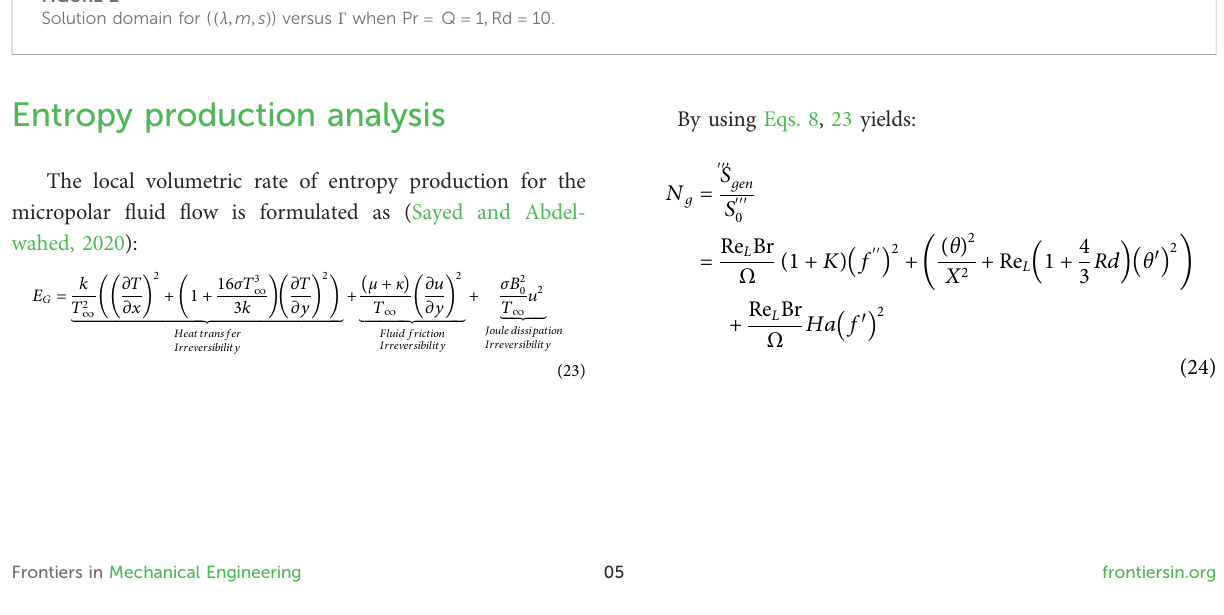
FIGURE 2 Solution domain for ( ( λ , m , s ) ) versus Γ when Pr (cid:3) Q (cid:3) 1 , Rd (cid:3)